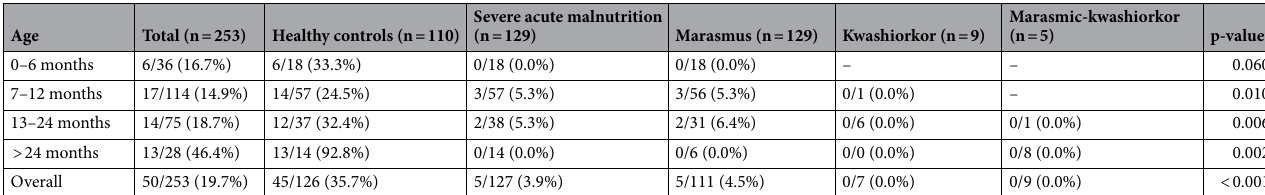
Table 2. Prevalence of Methanobrevibacter smithii detection in children according to age and nutritional status—weighted data (n = 253). a Weighted logistic regression comparing the proportion of M. smithii positive samples in severely malnourished children compared to healthy controls. When comparing the proportions by age group, there was no significant difference for children with severe acute malnutrition (p = 0.620), but the difference was highly significant for controls (p < 0.001).